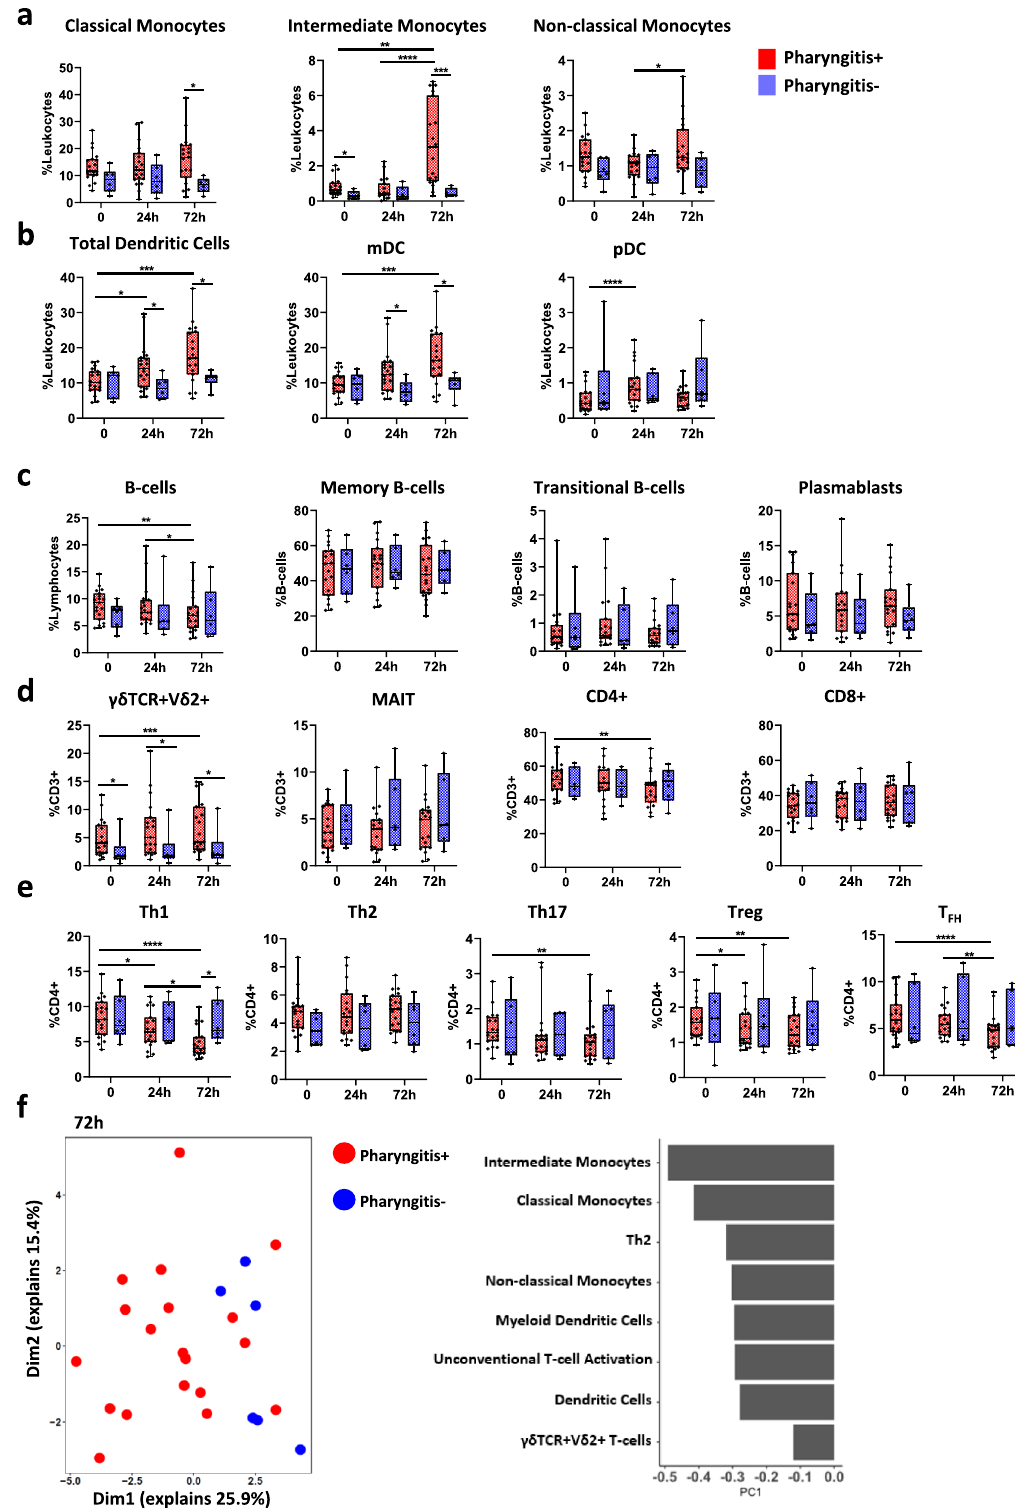
Fig. 3 Unique cellular pro fi les in participants that developed pharyngitis. a Differences in monocyte subsets at timepoint 0 h (pre-infection) 24h post- infection (24 h) and 72 h post-infection (72 h) between pharyngitis positive ( n = 19, red) and negative ( n = 6, blue) participants. b Dendritic cell subsets. c B cells and B-cell subsets. d γδ TCR + V δ 2 + T cells, MAIT cells, CD4 + T cells and CD8 + T cells. e CD4 + T cell subsets. f Unsupervised PCA analysis of cellular subsets between pharyngitis positive and negative individuals at 72 h post-infection and the top 8 factors contributing to differences. Data presented as boxplots show median ± IQR with min – max whiskers. A Friedman ’ s test was used to compare responses over time in P + and P − groups, while a Mann – Whitney U-test was performed to compare differences between P + and P − groups. All tests performed were two-tailed and a p -value <0.05 was considered signi fi cant; * p < 0.05, ** p < 0.01, *** p < 0.001, **** p < 0.0001.